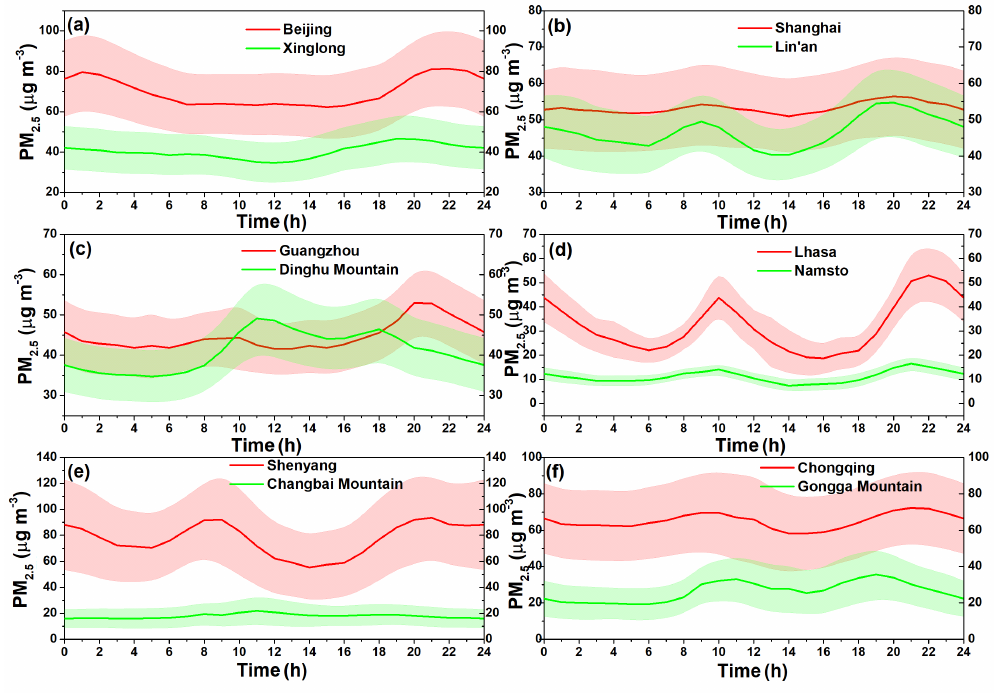
Figure 3. Diurnal cycles of PM 2 . 5 at six paired urban and background sites in the (a) North China Plain, (b) Yangtze River delta, (c) Pearl River delta, (d) Tibetan Autonomous Region, (e) North-east China region and (f) South-west China region. Shaded areas represent the error bars and one half of the standard